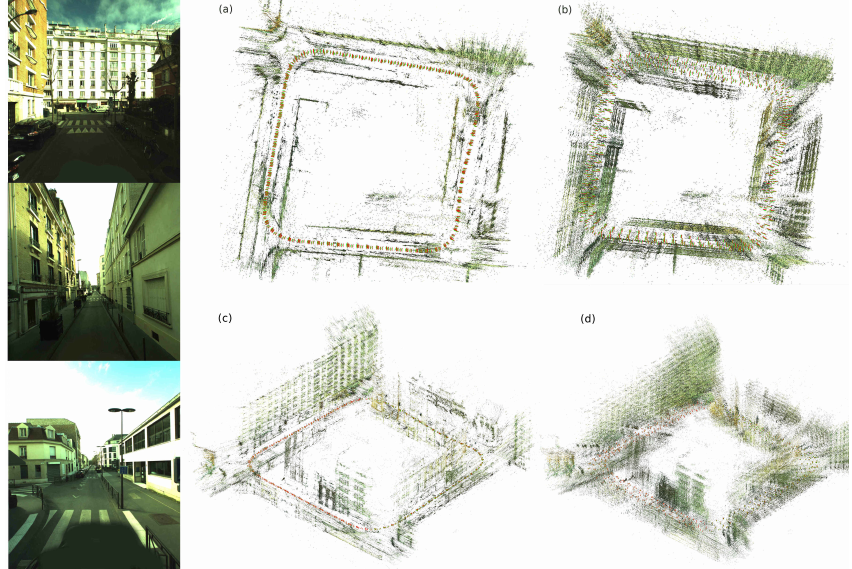
Figure 4. Left: excerpt from the CAR dataset. Right: (a) and (c) is the ground truth in top and side view; (b) and (d) is the equivalent E p + tri result. Note the multiple facade effect in (b) and (d) due to error accumulation, and leads to a low frequency drift, as plotted in Figure 3.